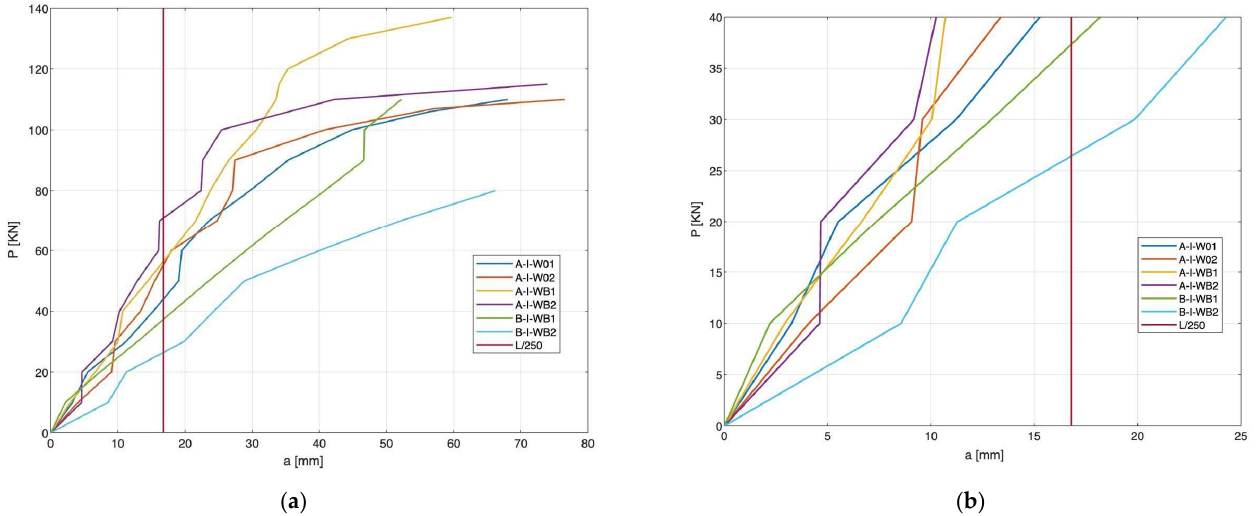
Figure 5. Load ‐ deflection curves for the tested beams. ( a ) Relationship until ultimate deflection; ( b ) Relationship between the development of the first crack and deflection limits.